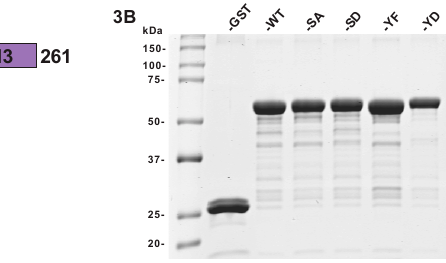
Figure 3. Phospho-Mutants of LASP1 Differentially Interact with Ago2. ( A ) Schematic diagram of designed LASP1 phosphorylation mutants. ( B ) Representative profile of purified GST-LASP1 single phospho-mutants: 1.5 nmol of each purified mutant was resolved by 10% SDS-PAGE and visualized by staining with Imperial Blue stain. ( C ) LASP1 single-mutant pulldown for Ago2: 1 mg of Bone-Un LASP1 KO total lysate was incubated with 1.5 nmol of each LASP1 single-mutant protein. Associated Ago2 was detected by immunoblot analysis and loading of GST-fusion proteins was visualized by Ponceau S staining. ( D ) Direct binding of LASP1 single-mutants to recombinant Ago2: 100 ng of purified recombinant Ago2 was incubated with 1.5 nmol of each purified single-mutant protein.